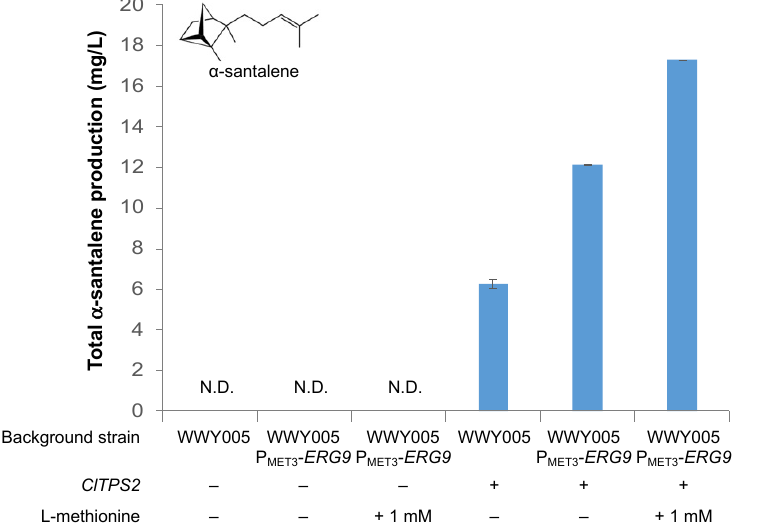
Figure 6. Effects of ERG9 repression on α -santalene production in engineered strains. + indicates that the gene was overexpressed. – indicates that the gene was not overexpressed. N.D. not detected.